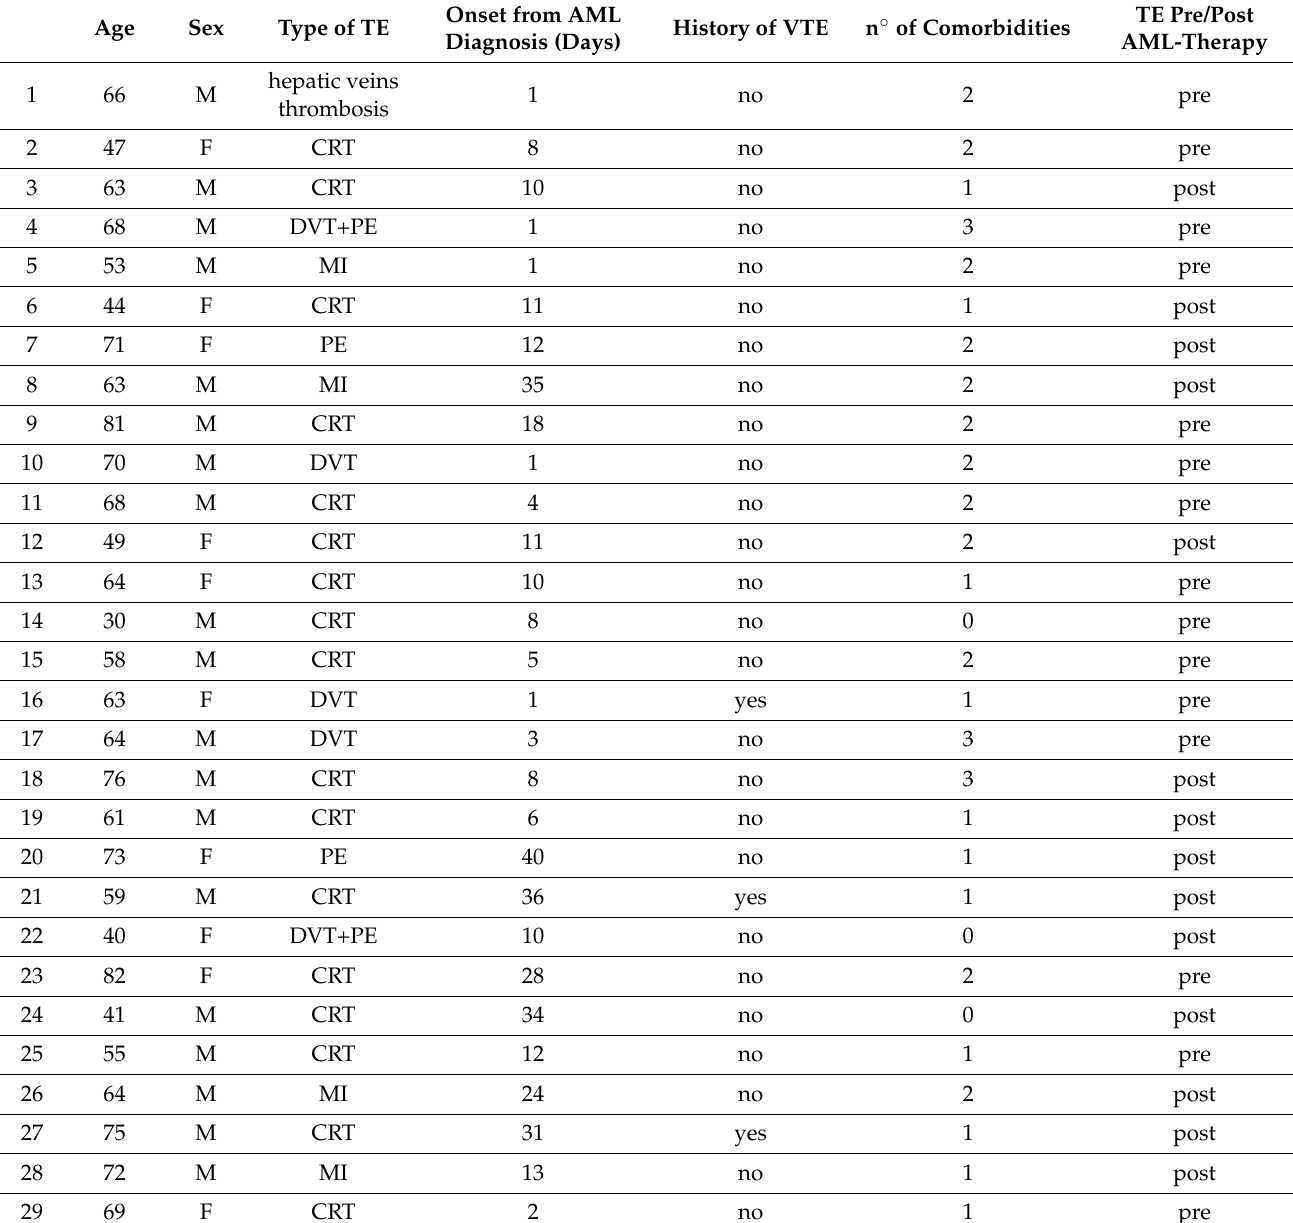
Table 2. Characteristics of thrombotic events occurred within 45 days from acute myeloid leukemia